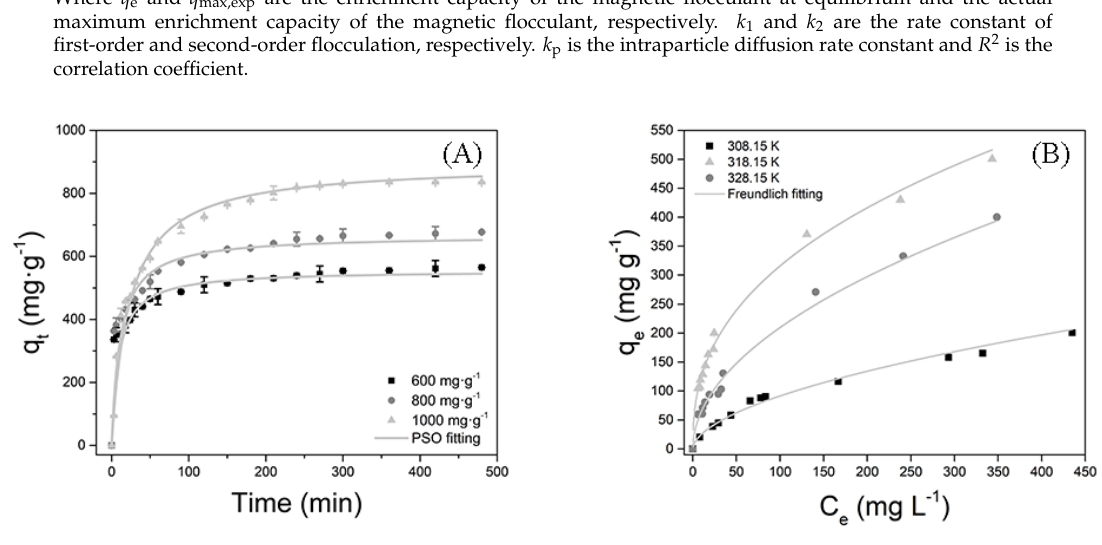
Figure 10. Enrichment kinetics of DCFS ( A ) and enrichment isotherms of DCFS ( B ) by TAPAM-PDA- Fe 3 O 4 treatment.